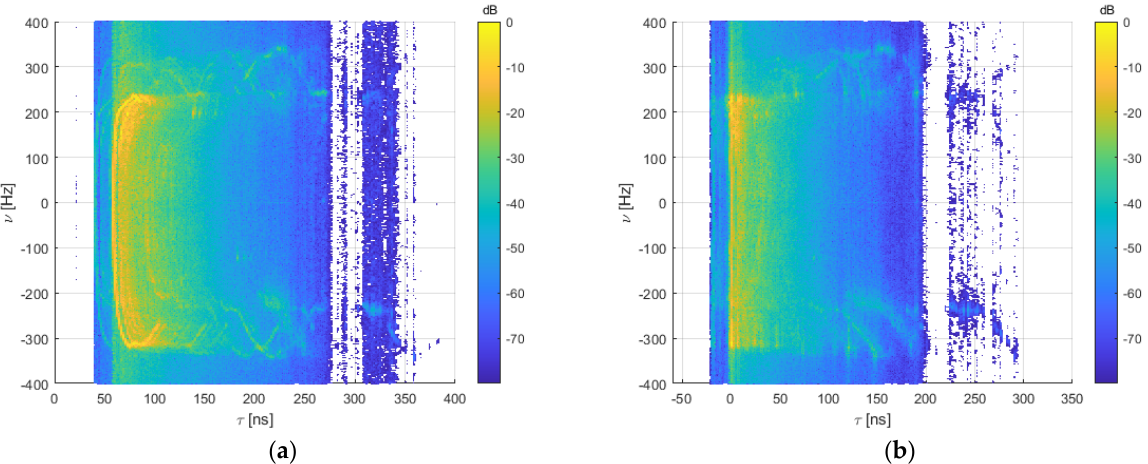
Figure 17. Delay-Doppler spectra from the alley campaign: ( a ) original data; ( b ) after aligning the responses with respect to the main path.